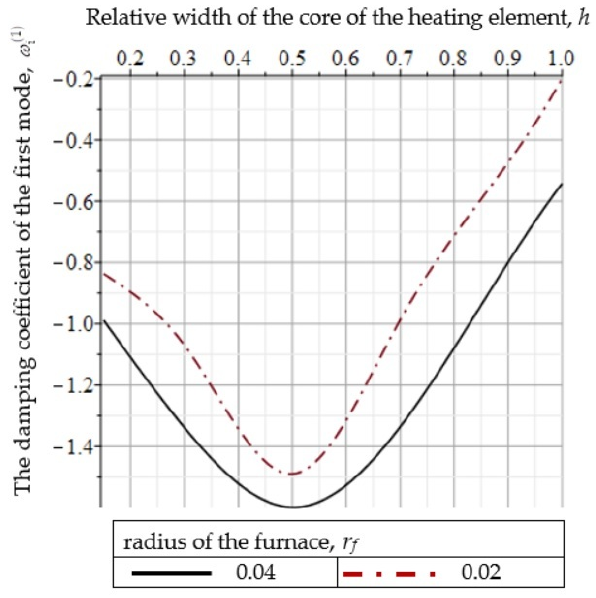
( 1 ) ω on the radius of the furnace and h . on the radius of the furnace and h . i i